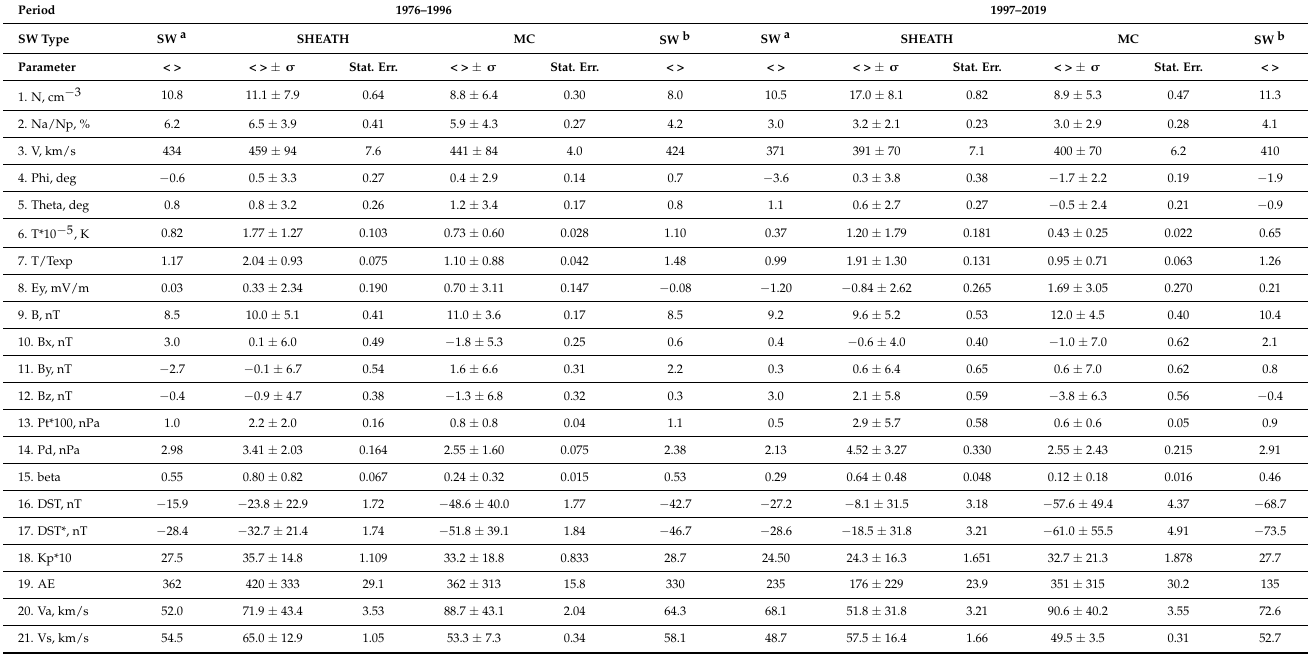
Table 7. Average parameters for sequence SW/SHEATH/MC/SW (Figure